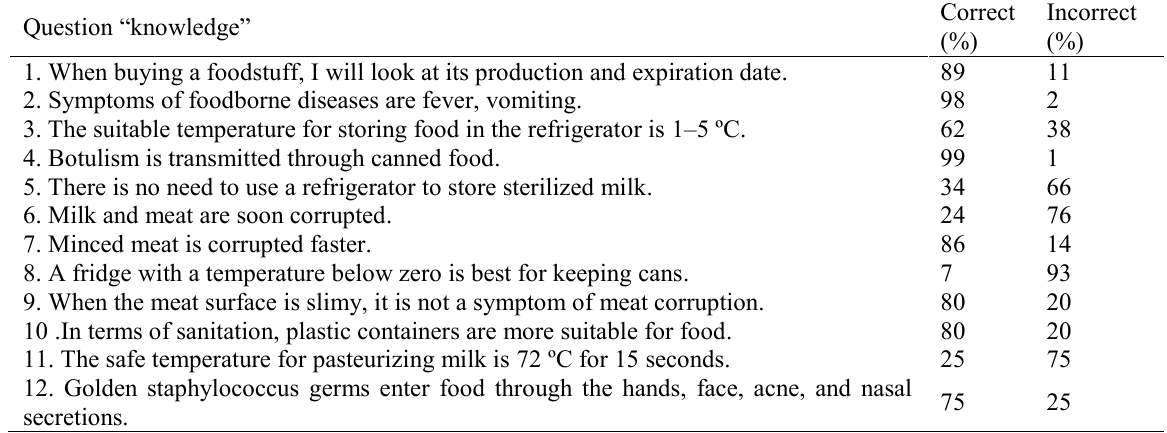
Table 2. Percentage of participants with correct and incorrect answers for food safety knowledge questions Question